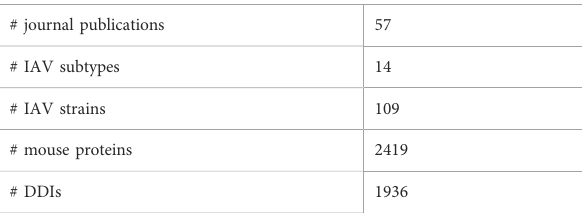
TABLE 2 Three-class virulence classi fi